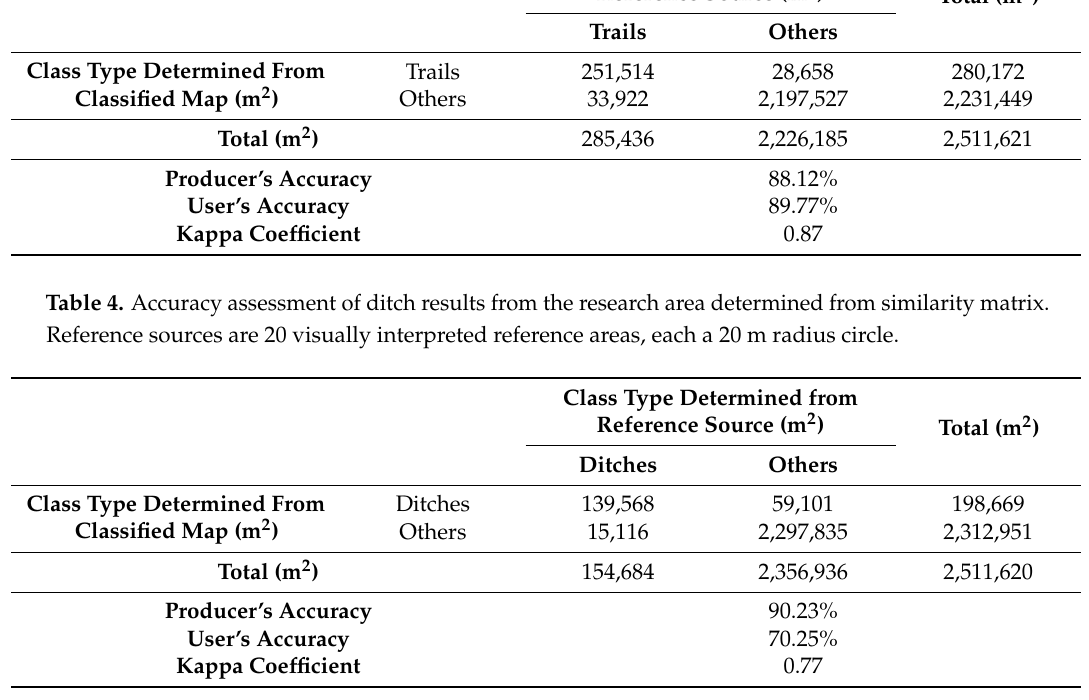
Table 5. Accuracy assessment of field results from the research area determined from similarity matrix. Reference sources are 20 visually interpreted reference areas, each a 20 m radius